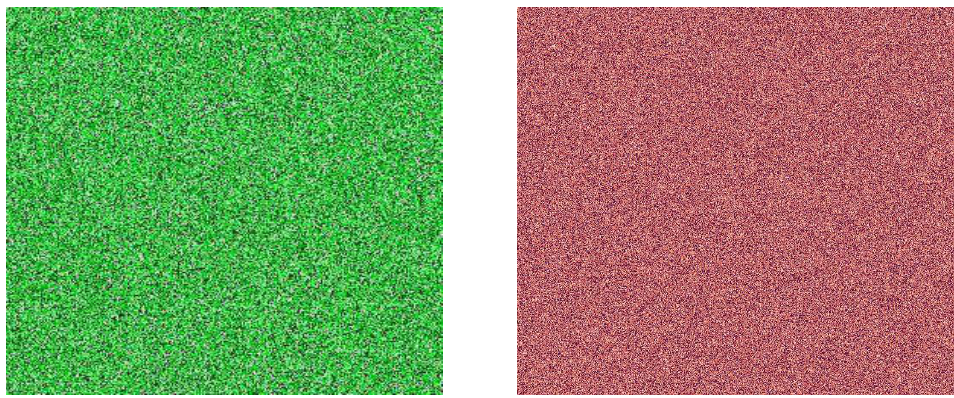
Figure 5. The cipher fractal image (left) and non-fractal image (right) from Figure 1 after using the 2D QRT linear map from Eq. (28) with 0.15  and 1 3 0 r 